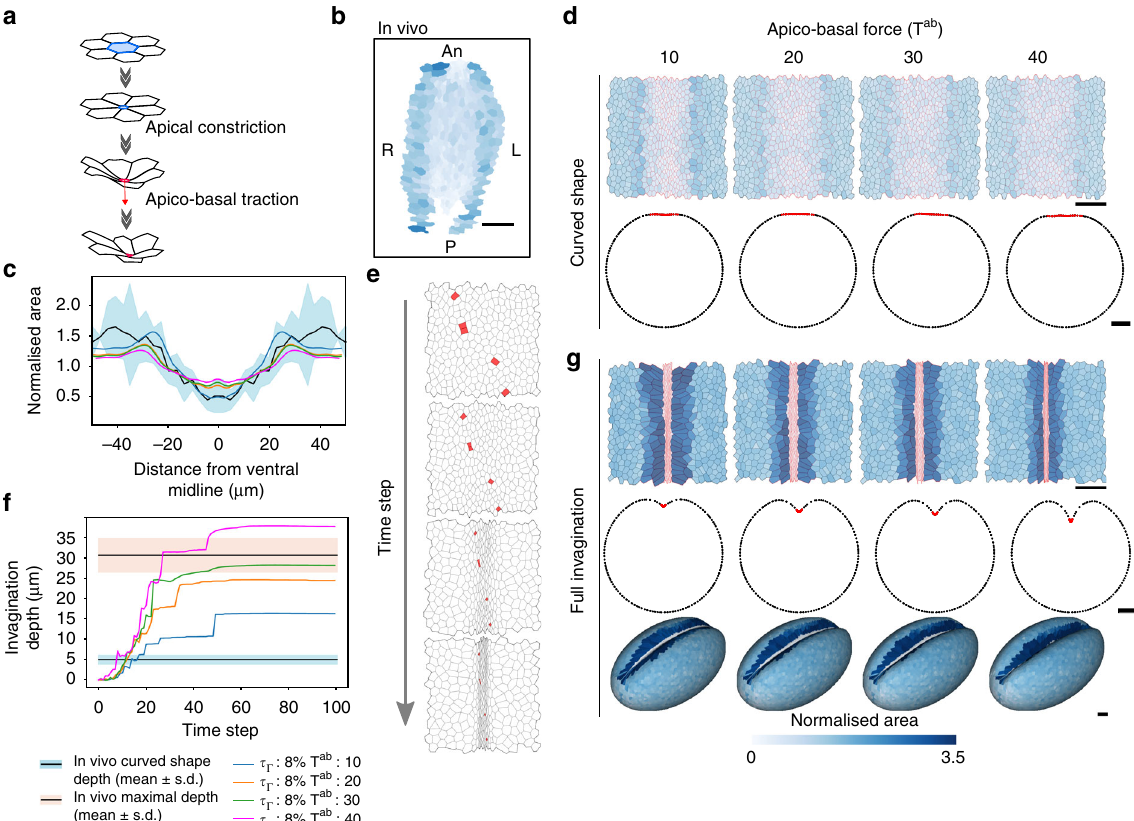
Fig. 8 Apico-basal traction is required for mesoderm invagination in a 3D biophysical model. a Scheme of the apical constriction and the apico-basal traction processes. First, the cell constricts its apex (blue) until its surface area falls under a critical threshold. Then, the cell exerts an apico-basal force (red arrow) perpendicular to the apical surface. b Same as Fig. 4c. Central region of the curved-shaped mesoderm in vivo. Apical area is color-coded (see color bar in g ). c Comparison of cell area in the curved-shaped mesoderm in vivo and in the model. Graphs show the normalized cell area in vivo (mean: black line, s.d.: blue band, n = 3) and in simulations for different values of apico-basal force T ab (color-coded as indicated in f ) with respect to the distance from the ventral midline. d Top row: Images show the central region of the curved-shaped mesoderm in simulated embryos for different values of apico-basal force T ab and an apical contractility increase rate τ Γ = 8%. Apical area is color-coded and cell edges are red in the mesoderm and black elsewhere (see color bar). Bottom row: Tissue deformation of the modeling results of curved-shaped embryos. For each simulation, curved shape was de fi ned when the invagination depth corresponds to the in vivo depth of curved-shaped embryos. Scale bar: 25 µ m. e Time-lapse images of the ventral part during mesoderm invagination showing the apical extrusion of a few cells (marked in red). f Invagination depth as a function of time for different values of apico-basal force T ab (color-coded as indicated below) and an apical contractility increase rate τ Γ = 8%. The black line with a blue (resp. pink) border denotes the average depth measured in vivo when the embryo adopts a curved shape (resp. at the end of invagination). g Same as ( d ) at full invagination stage for upper and middle rows. Bottom: Tissue deformation (3D view) of the simulation results at full invagination stage. Scale bar: 25 µ m See also Supplementary Fig. 4